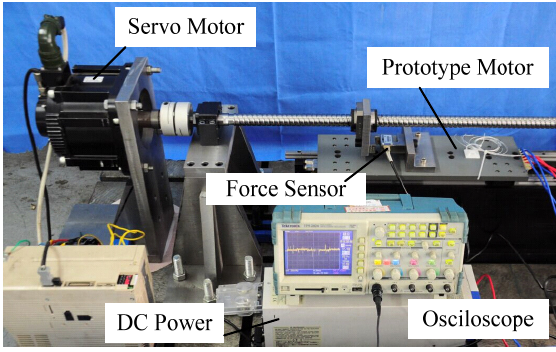
Figure 11. The test platform of the LSM.